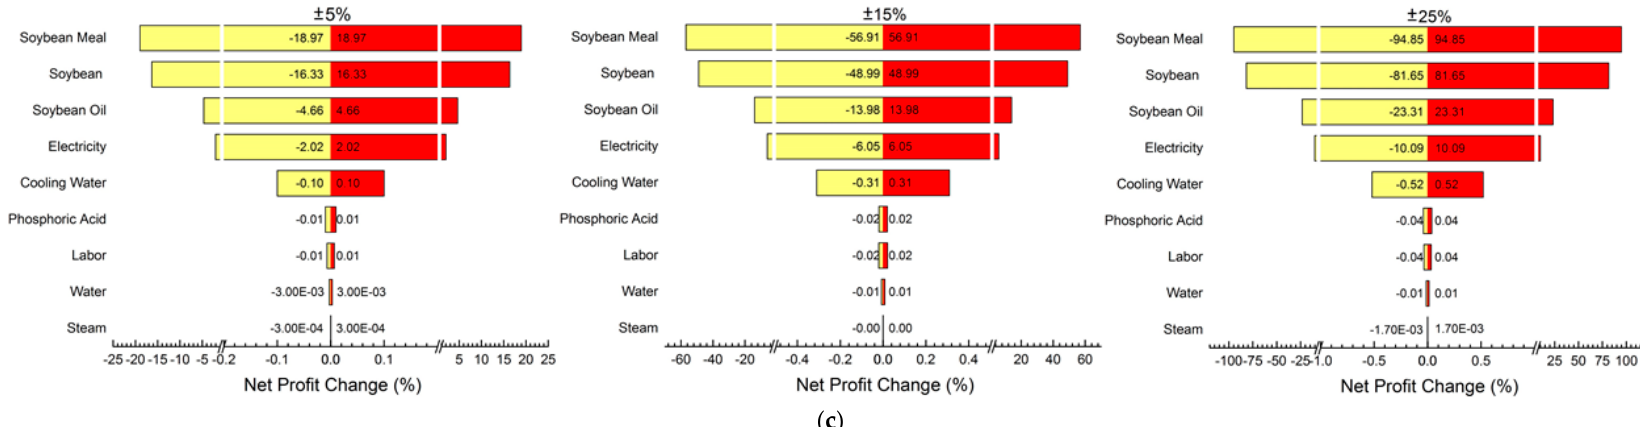
Figure 9. Net profit changes with changes in operating costs and retail prices of ± 5%, ± 15% and ± 25%. The increase in operating costs typically results in net profit decreases, and vice versa. ( a ) 12.81 million kg soybean oil production per annum; ( b ) 89.67 million kg soybean oil production per annum; ( c ) 398.67 million kg soybean oil production per annum.